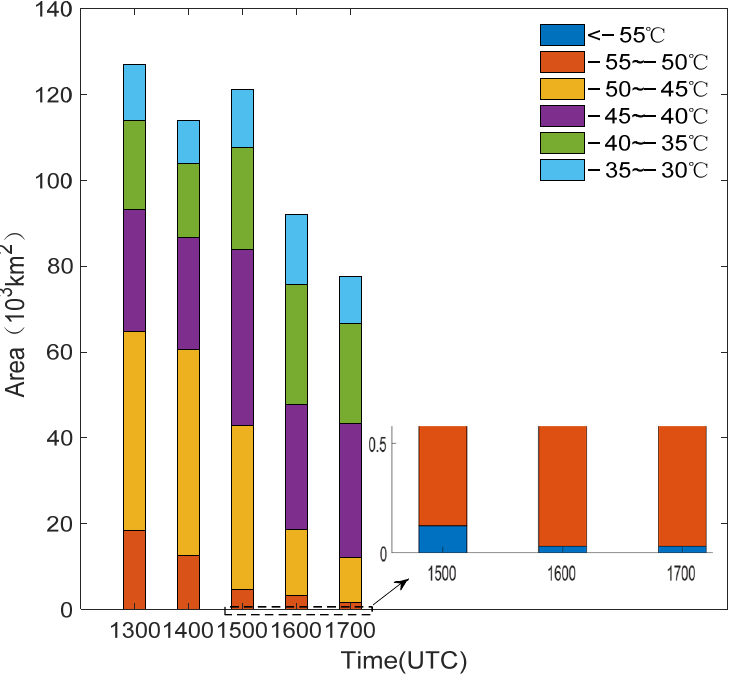
Figure 5. Evolution of cloud top brightness temperature area at different moments of the parent thunderstorm on 31 May 2017. thunderstorm on 31 May